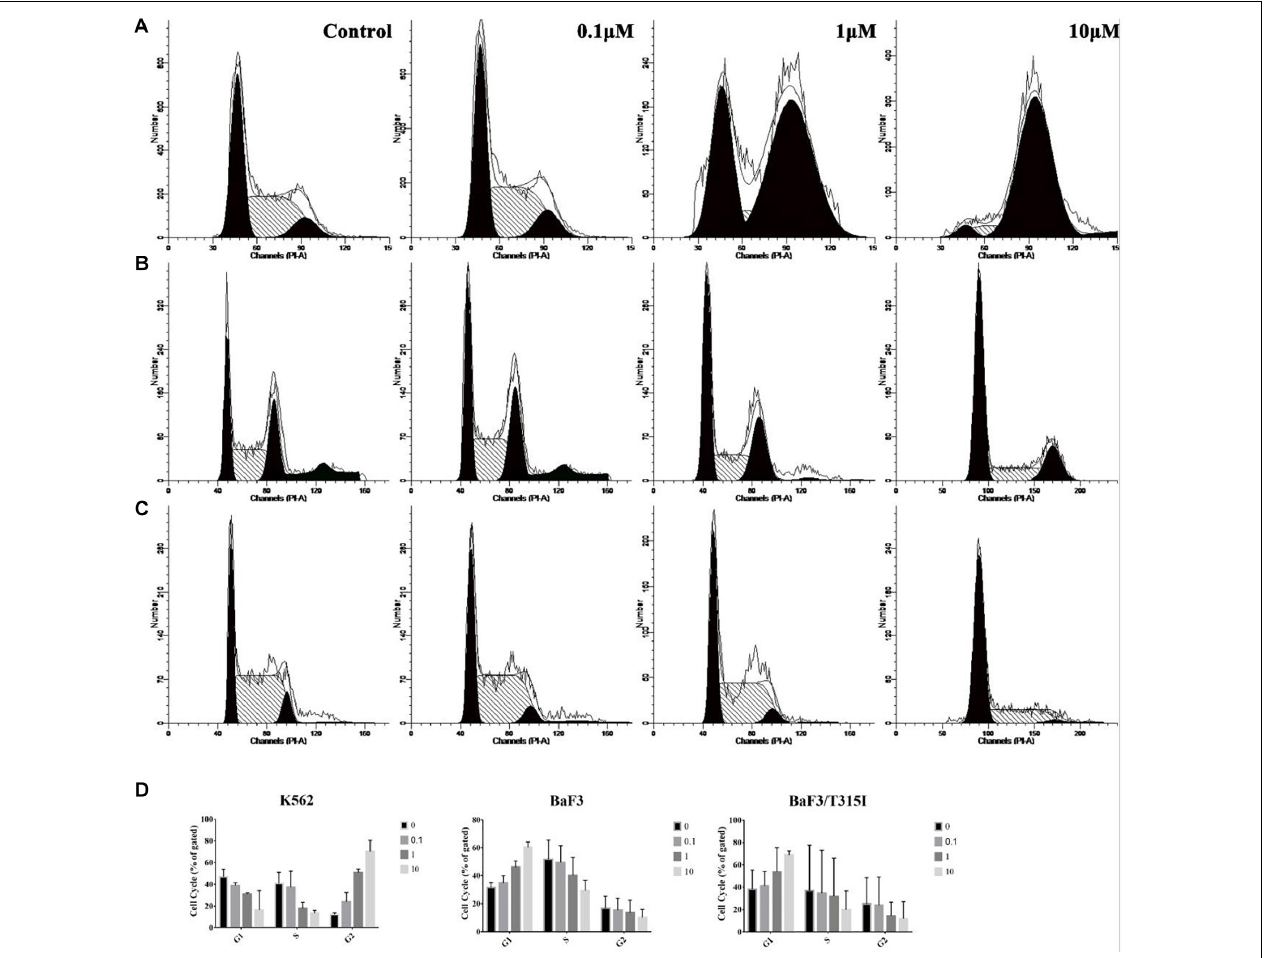
FIGURE 9 | The effect of ZINC21710815 on the cell cycle in K562, BaF3/WT and BaF3/T315I leukemia cells. (A) K562 leukemia cells were incubated with various concentrations of ZINC21710815 for 24 h at a density of 1 × 10 6 cells/well. (B) BaF3 leukemia cells were incubated with various concentrations of ZINC21710815 for 24 h at a density of 5 × 10 5 cells/well. (C) BaF3/T315I leukemia cells were incubated with various concentrations of ZINC21710815 for 24 h at a density of 5 × 10 5 cells/well. (D) The relative percentages of the cell cycles for K562, BaF3/WT, and BaF3/T315I leukemia cells were calculated using ModFit LT software. The results are represented as the mean ±